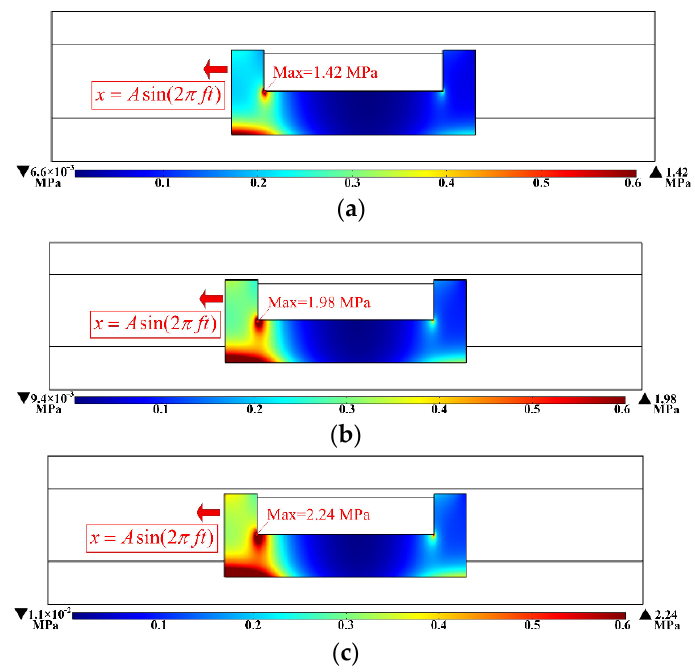
Figure 14. Stress distribution under different currents of the MR damper. ( a ) Current of 0.6 A, ( b ) current of 1 A, ( c ) current of 1.4 A.